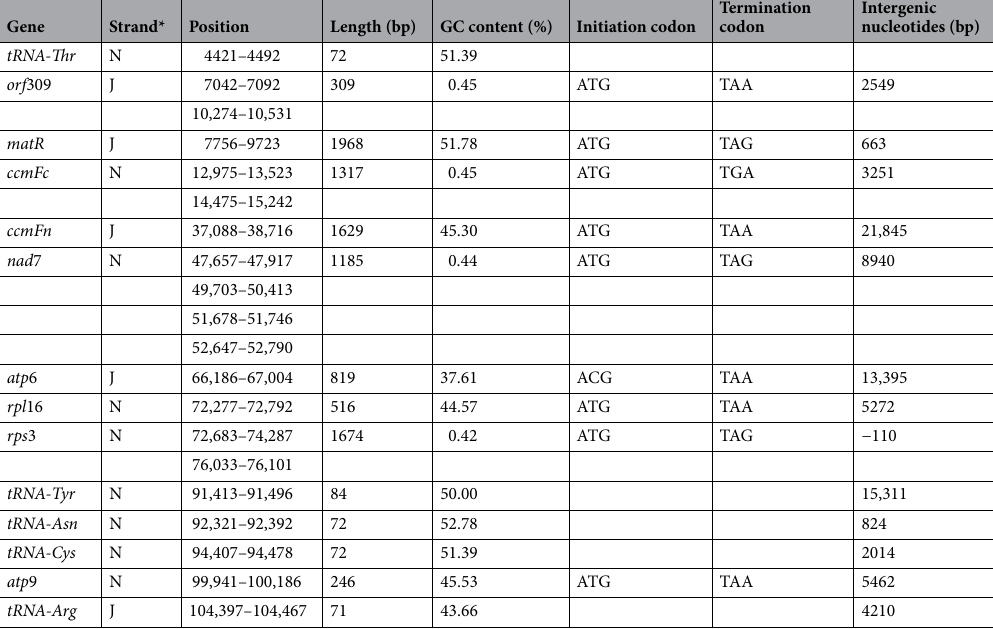
Table 1. Annotations and characteristics of mitochondrial genome 1 of Neolamarckia cadamba. *J stands for the direction of a gene from 5 ′ to 3 ′ , and N for the direction of a gene from 3 ′ to 5 ′